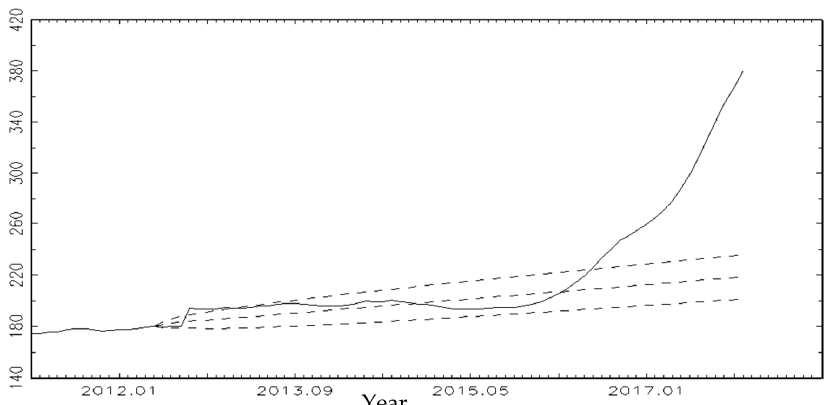
Figure A6. Time series forecasting for dphea, the in-sample January 2000–May 2012, and the out-of-